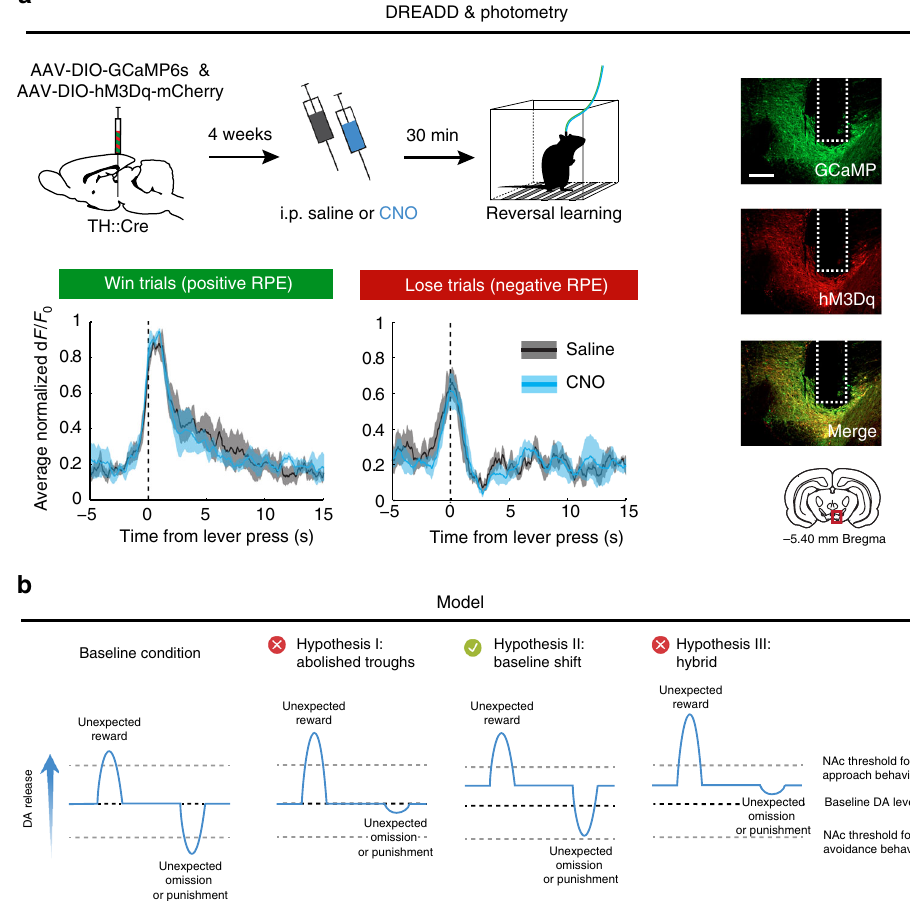
Fig. 7 Reward prediction error processing after mesoaccumbens stimulation. a Animals were co-injected with GCaMP6s and Gq-DREADD and tested for reversal learning after injection of saline or CNO. VTA neurons responded in a comparable way during reversal learning after saline and CNO treatment (repeated measures in n = 4 animals; ANOVA, CNO×time interaction effect, win trials, p = 0.39; lose trials, p = 0.38). See Supplementary Fig. 9a for individual animals. Scale bar, 1 mm. Data are shown as mean (solid line) ± standard error of the mean (shading). b Proposed mechanisms: (I) hyperactivity of NAc-projecting VTA DA neurons leads to impaired coding of negative reward prediction error troughs, (II) hyperactivity shifts baseline NAc DA levels, thereby preventing the exceedance of a negative reward prediction error threshold in the NAc and impairing the ability to learn from negative feedback, or (III) a combination of I and